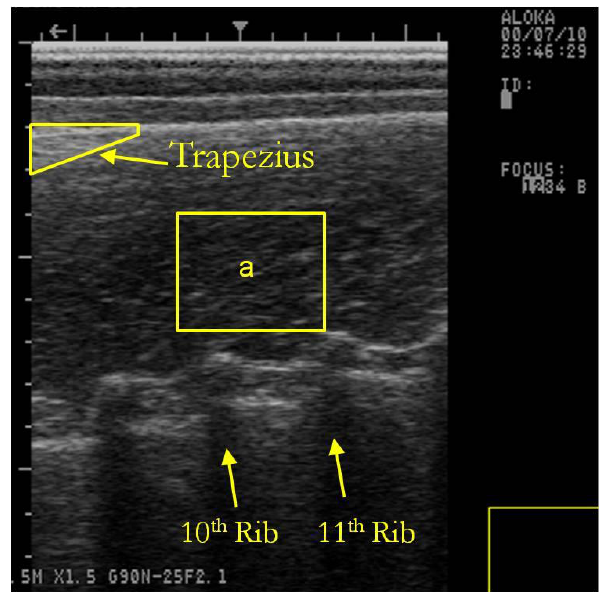
Figure 1. Example of an ultrasound image used for the prediction of intramuscular fat percentage. a Region of interest: 100×100 pixel area. 10 image parameters generated from this